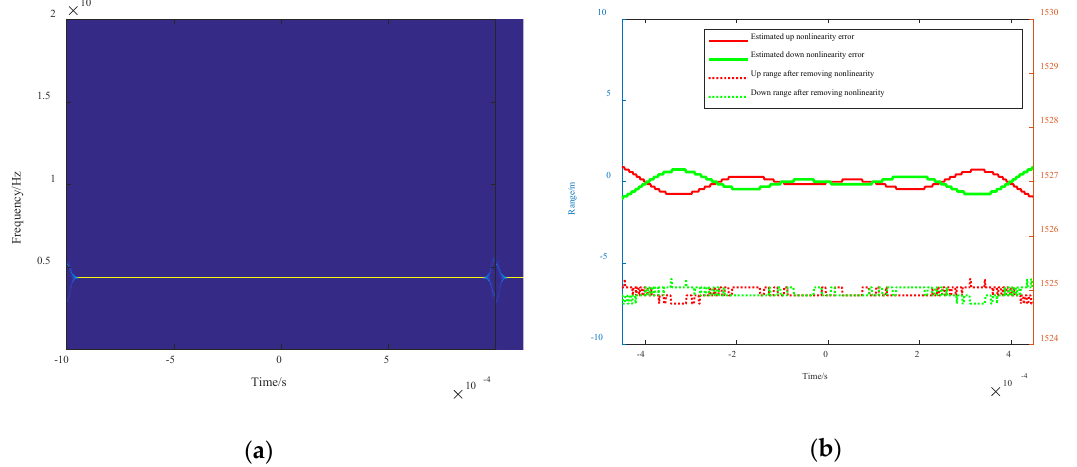
Figure 7. ( a ) The second − order SST results of ideal reference dechirp signal; ( b ) The estimated nonlinearity errors (shown by the left axis) and the preliminarily compensation results of the instantaneous measurement ranges (shown by the right axis).